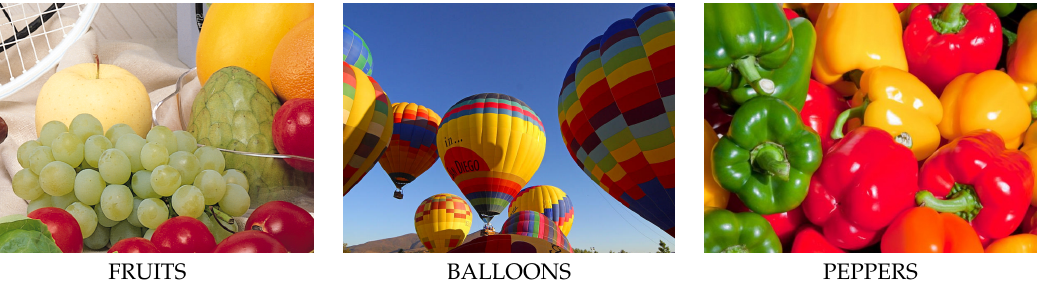
Figure 11. Representative test images from benchmark dataset [36] for which numerical results were